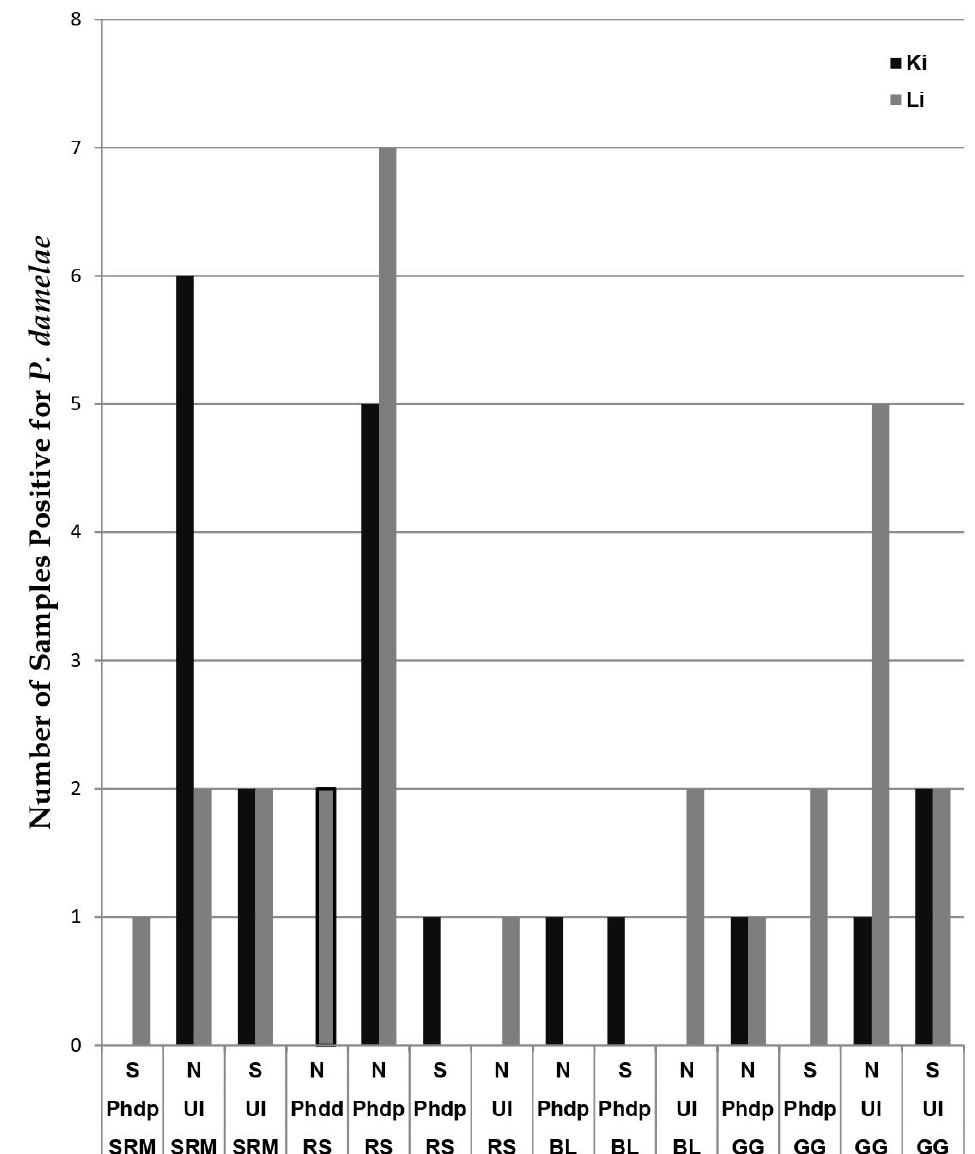
Figure 2. Samples divided by fish species: striped red mullet (SRM), round sardinella (RS), brushtooth lizardfish (BL) and goldband goatfish (GG), with depictions of number of samples identified as P. damselae subsp. piscicida (Phdp), P. damselae subsp. damselae (Phddª) or P. damselae with no subsp. (UI = Unidentified). Samples are further divided by regions of their origins (N = North, CS = Central-South), and by organ they were found in (Ki = Kidney, Li = Liver). The purpose of the three-gene multiplex PCR screening approach was to try and determine the P. damselae subspecies. Five of these sequences were negative for all three ª Bar outlined in black to single out this subspecies. genes ( Car , ureC and toxR ) and therefore could not be unequivocally identified as being of either subspecies. They were thus listed only as P. damselae . The two sequences listed as Phdd were positive for ureC , while all the rest (i.e., those identified as Phdp) were positive for Car and/or toxR